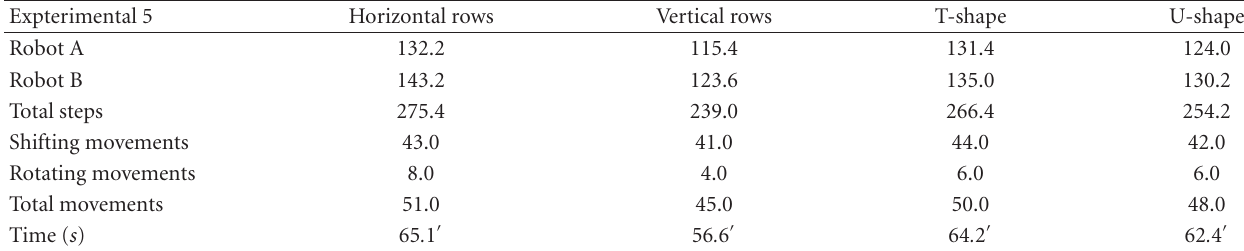
Table 6: Eye gaze used to initialise task